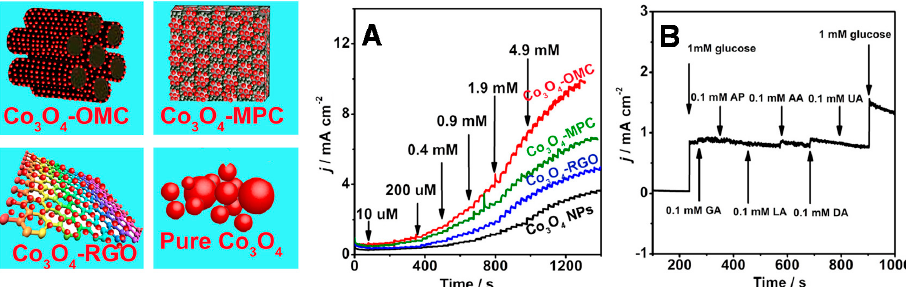
Figure 8. ( A ) Typical j – t curves obtained at glassy carbon electrodes (GCE) modified with Co 3 O 4 nanocrystals (GCE/Co 3 O 4 NPs), or with Co 3 O 4 nanocrystals-decorated reduced graphene oxide (GCE/Co 3 O 4 -RGO), macroporous carbon (GCE/Co 3 O 4 -MPC), and ordered mesoporous carbon (GCE/Co 3 O 4 -OMC) on the successive injection of glucose in 0.1 M NaOH solution at 0.55 V vs. Ag/AgCl, on which the concentration denoted the final glucose concentration; the corresponding modifiers are illustrated on the left. ( B ) The j – t curve of GCE/Co 3 O 4 -OMC with the successive addition of 1 mM glucose, 0.1 mM interference substances, and 1 mM glucose at +0.55V vs. Ag/AgCl (reproduced from [164]).